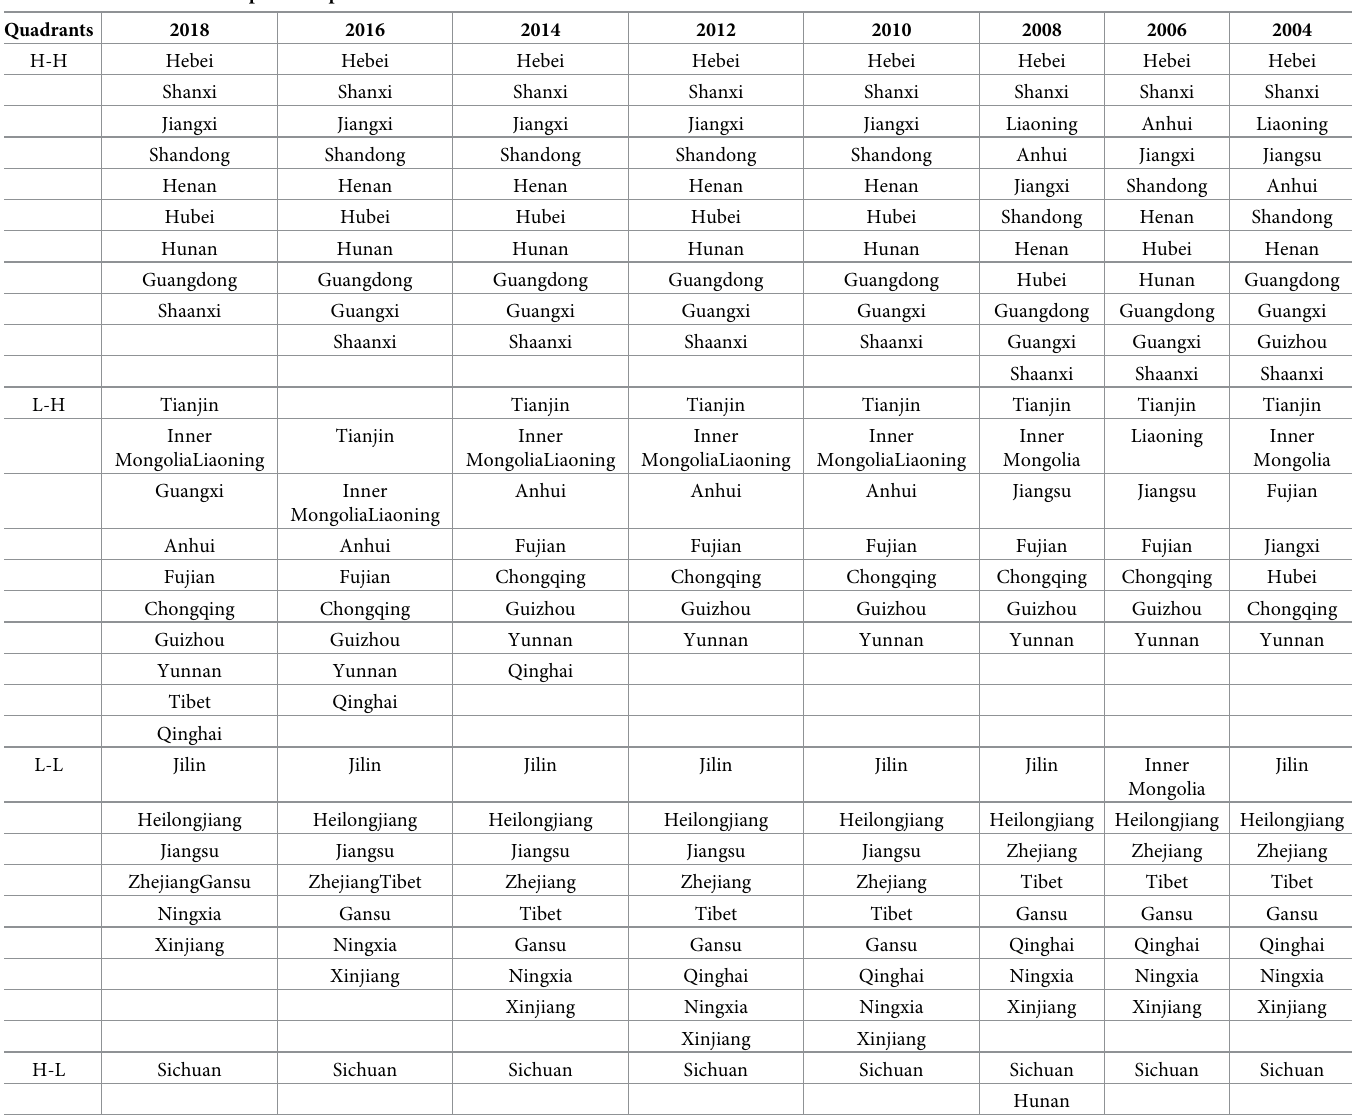
Table 5. Cluster of the development of public health services.